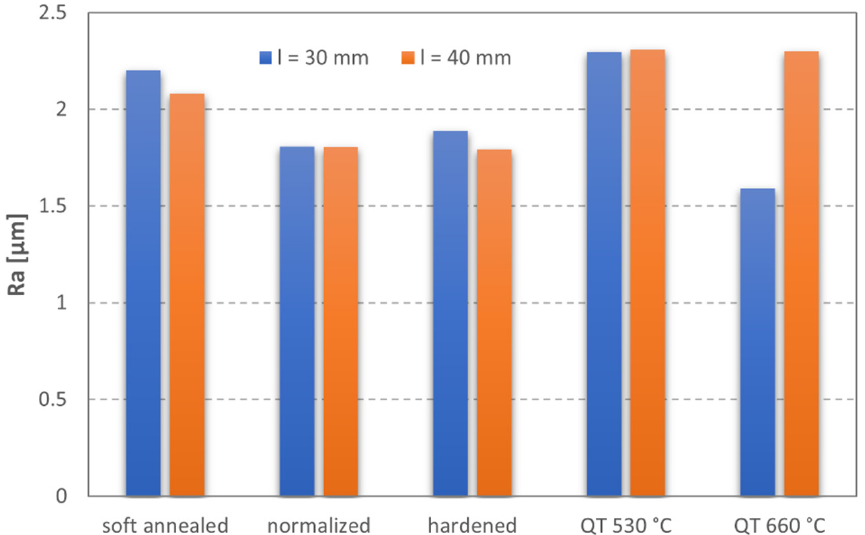
Figure 4. Comparison of the Ra parameter for the analyzed states of C45 steel.